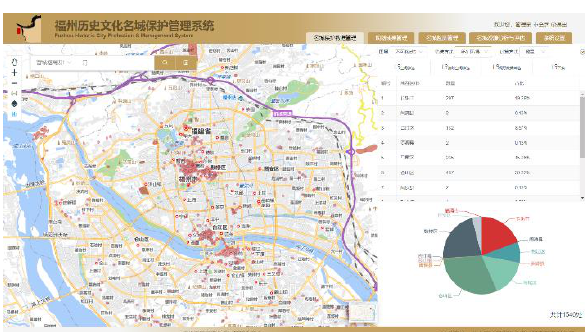
Figure 5. The statistical analysis of the cultural relics of Fuzhou